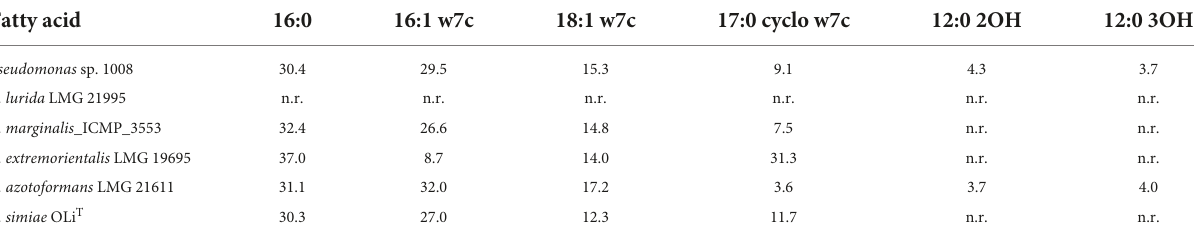
TABLE 5 Comparison of the relative abundance (%) of major cellular fatty acids of Pseudomonas sp. strain 1008 and its closest phylogenetic relatives (see Table 4 and Figure 4 ). Fatty acid